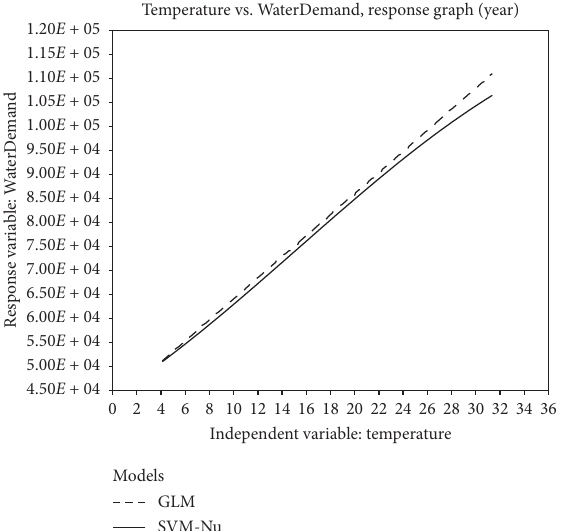
Figure 11: The reaction of water consumption to air temperature with winter conditions using GLM and SVM-Nu models.